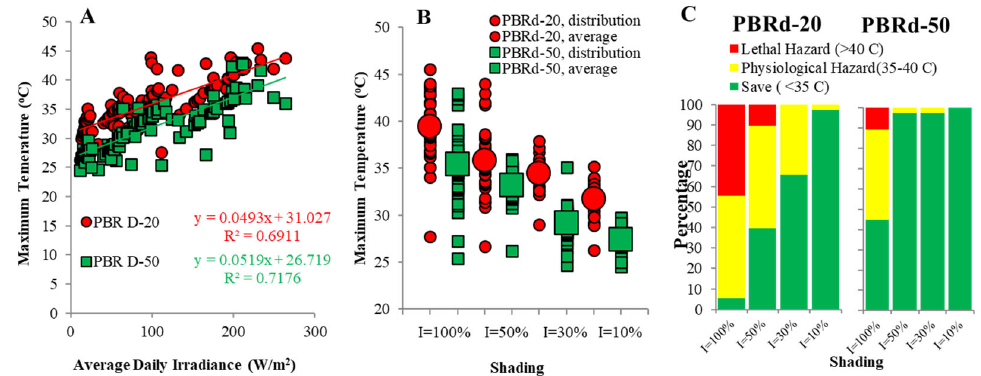
Figure 3. Effect of daily irradiance, paranet shading, and column size on temperatures ( A , B ) and hazard level ( C ) of outdoor A. platensis culture in a tropical area. hazard level ( C ) of outdoor A. platensis culture in a tropical